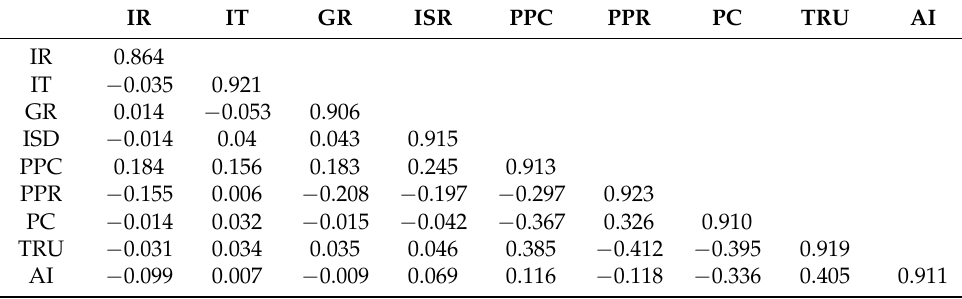
Table 5. Correlation coefficients and square root of